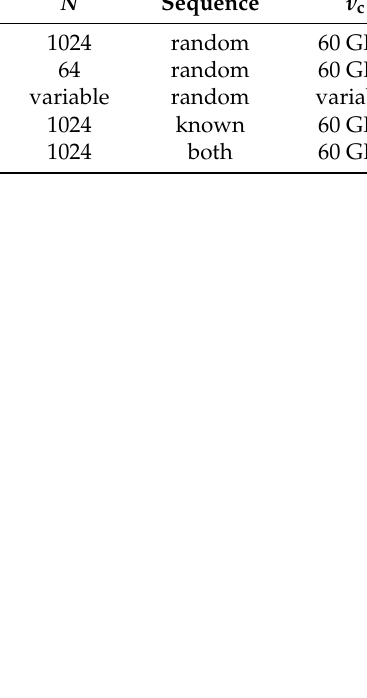
Figure 3. CRB for 2D localization by five randomly placed antennas in the plain of the array. The locations of the antennas are marked by triangles. The obtained CRB is for a random Gaussian sequence and parameters SNR 0 = 10 dB and N =